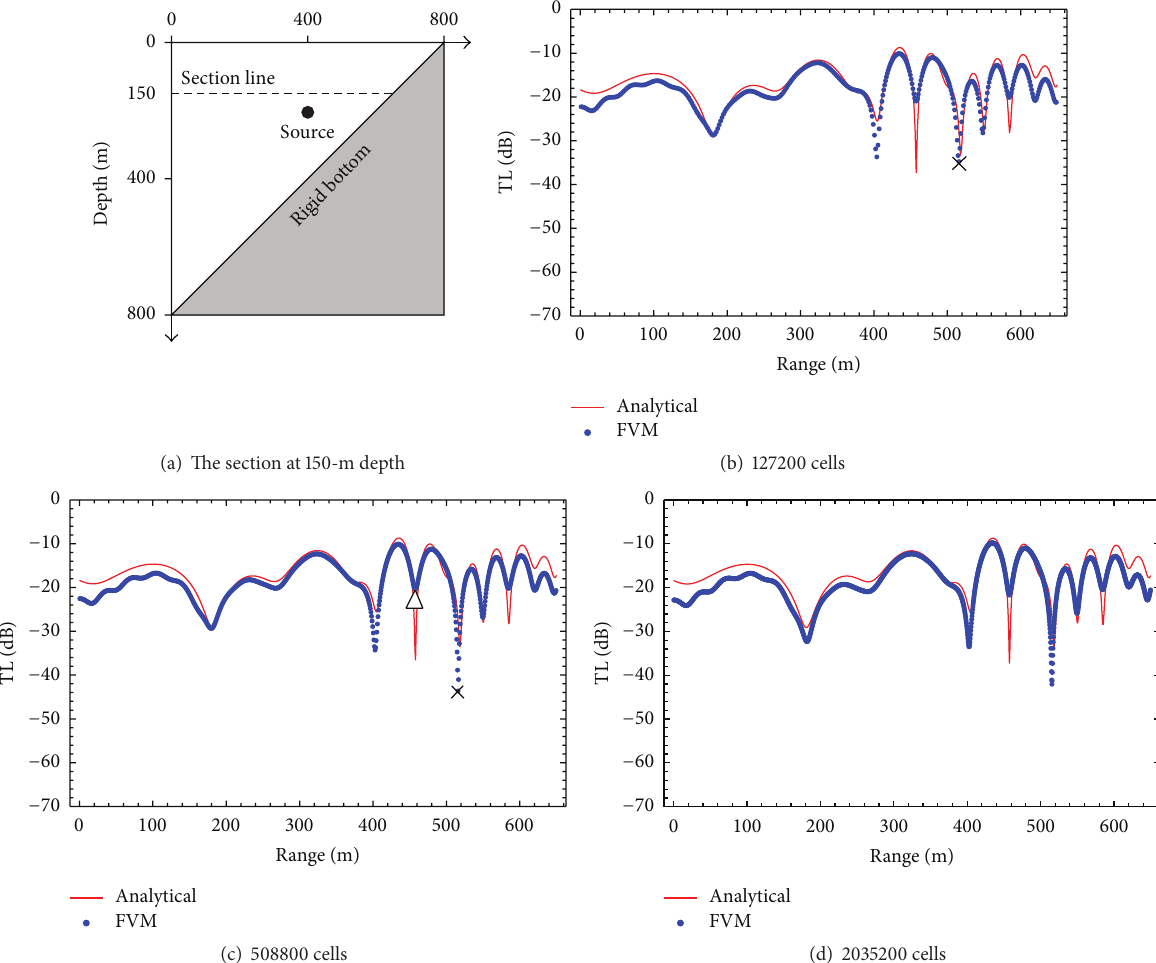
Figure 2: Comparison of the Fourier transform of the FVM result 𝑝 at 150-m depth and the section of the analytical solution to the Helmholtz equation at the same depth: (a) The section line; (b) TL result in a mesh of 127200 cells; (c) TL result in a mesh of 508800 cells; (d) TL result in a mesh of 2035200 cells. The continuous line indicates the analytical solution and the descrete dots indicate the result of the FVM